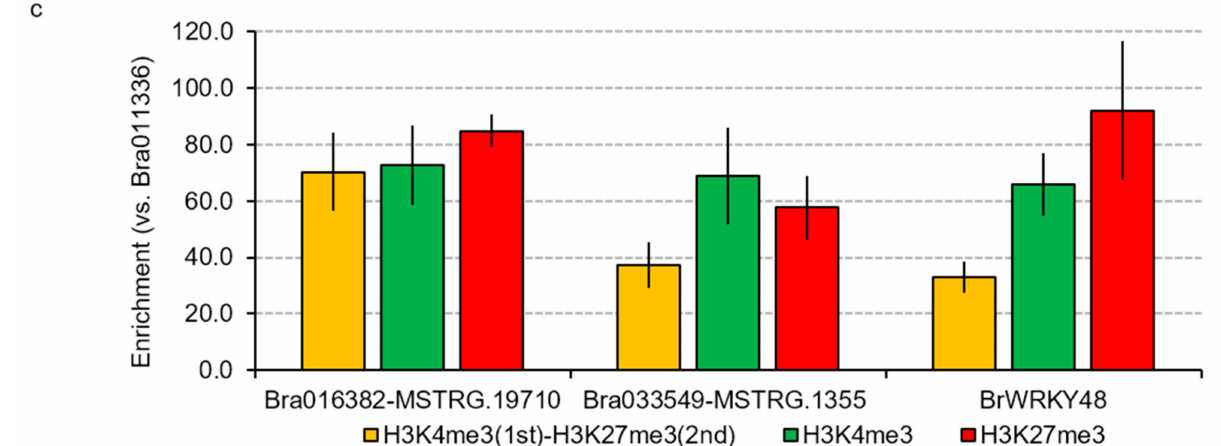
Figure 4. Bivalent histone modification in the genic regions and their paired NATs. ( a , b ) Visualization of H3K4me3, H3K36me3, and H3K27me3 peaks by the Integrative Genomic Viewer (IGV) by ChIP-seq. Black and gray boxes represent the exon regions of genes or NATs, respectively. Arrows represent the direction of transcription. Arrowheads represent the position of primer sets for sequential ChIP-qPCR. ( c ) Sequential ChIP-qPCR analysis in 14-day leaves in RJKB-T24. Bra011336 that does not have H3K4me3 and H3K27me3 is used as the reference gene for qPCR. A previous study using sequential ChIP-qPCR showed that BrWRKY48 has both H3K4me3 and H3K27me3 marks [26]. Values are means ± standard error (s.e.; three biological and technical replicates) of relative H3K4me3,